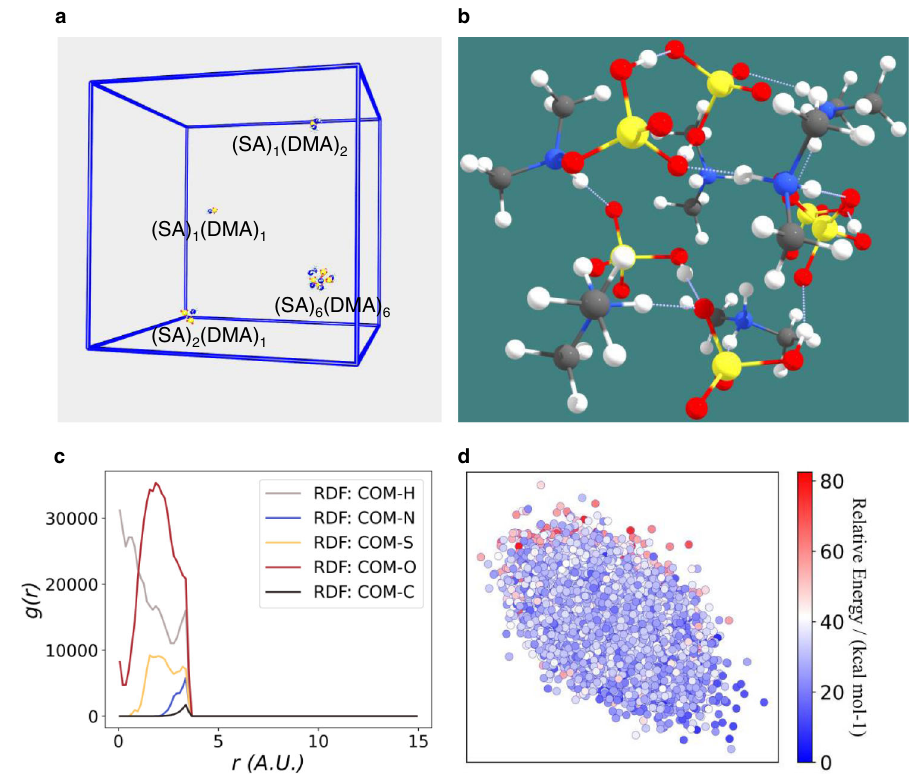
Fig. 3 | Structural distribution for (SA) 6 (DMA) 6 isomers derived from deep neural network-based force fi eld (DNN-FF)-based molecular dynamics (MD). a shows a snapshot of MD at 1ns. The cyan, white, red, blue, and yellow circles representC,H,O,N,andSatoms,respectively.TheNandSatomradiiareincreased threefoldforclarity. b Themoststableisomerinthetrajectory. c Radialdistribution